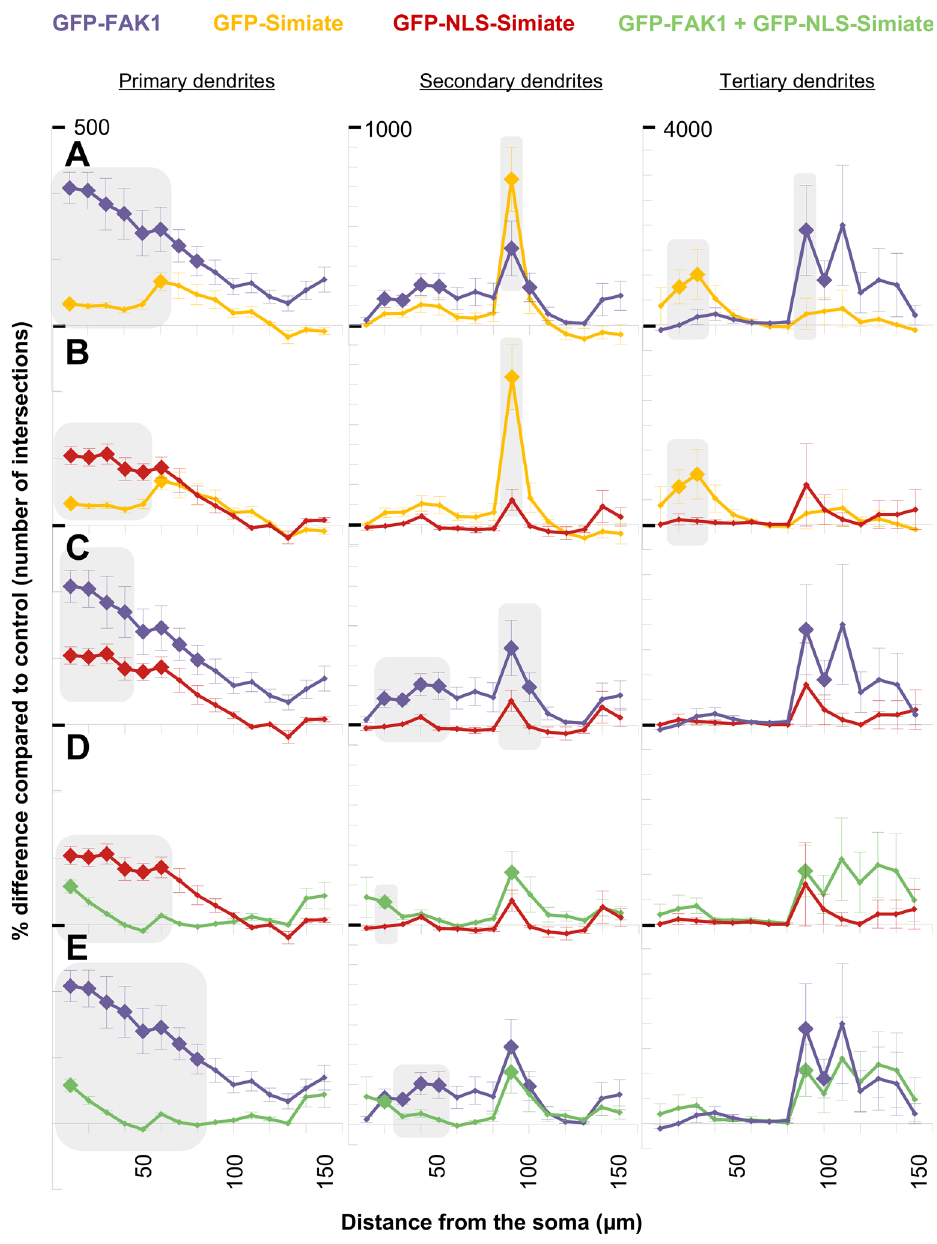
Figure 10. Sholl analyses of primary, secondary and tertiary dendrites reveal Simiate and FAK1 to influence neuronal arborisation in distinct ways. In all graphs, big rhombs indicate changes significantly different from control (GFP expressing neurons), while grey boxes highlight significant differences between constructs. Please note the different scaling between primary (500% maximum deviation), secondary (1000% maximum deviation) and tertiary dendrites (4000% maximum deviation). ( A – E ) Constructs are compared according to dendrite order and distance to the soma. For all constructs, n equals 12–14. Further statistical details are shown in Suppl. Table